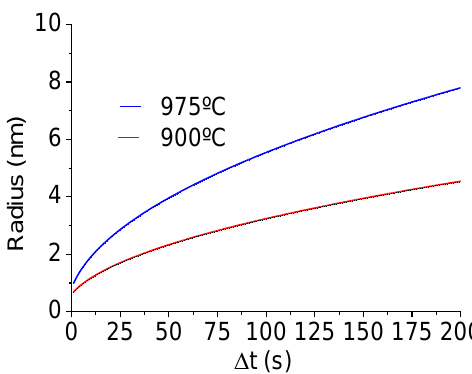
Figure 4. Precipitate size (radius) growth vs. time ( ∆ t > τ ) for VCN precipitates. Equation (8). Figure 4 . Precipitate size (radius) growth vs. time (Δ t > τ) for VCN precipitates. Equation (8).